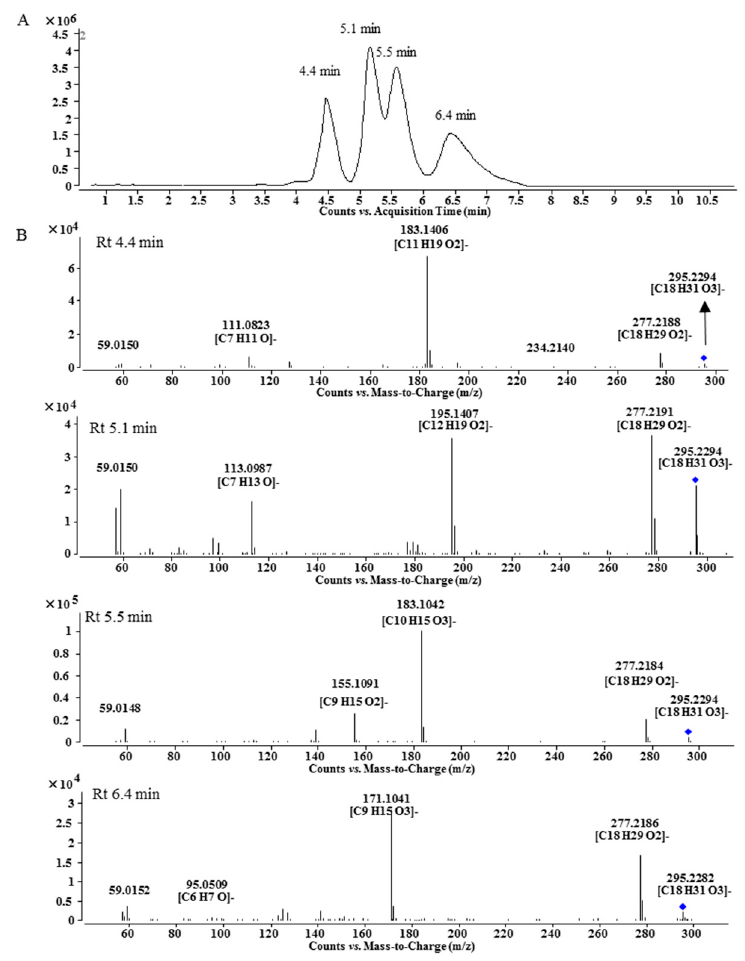
Molecules 2016 , 21 , 437 6 of 17